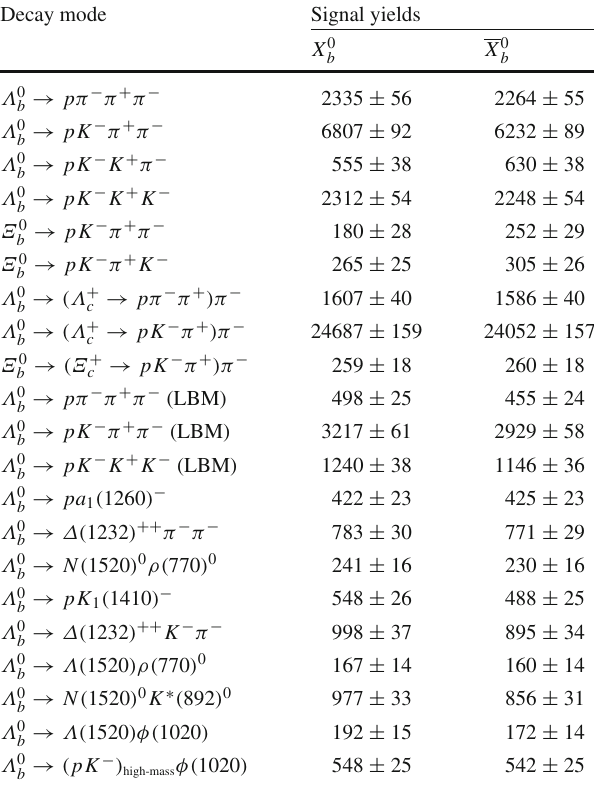
Table 4 Signal yields for each decay mode, summed over all trigger configurations and years of data taking Decay mode Signal